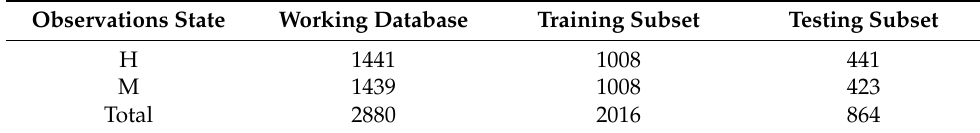
Table 5. Distribution of the observations in each subset.